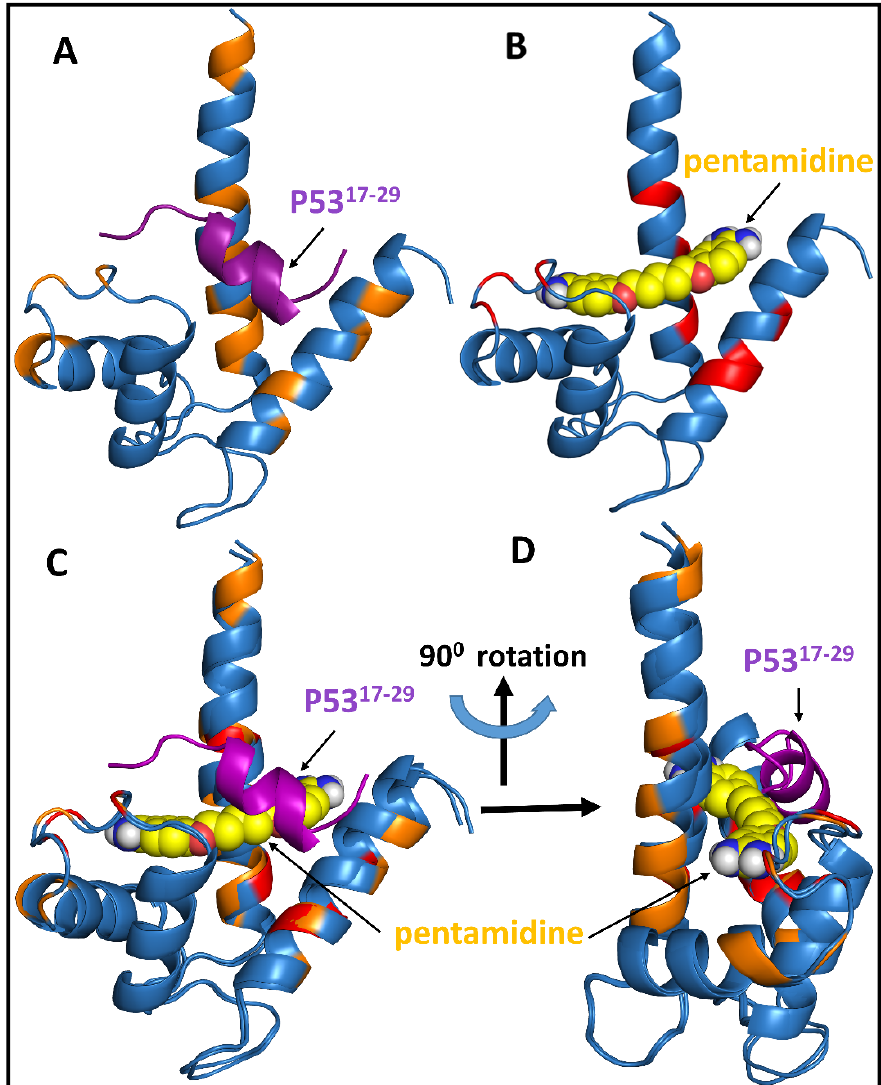
Figure 6. Two complex structures S100P-p53 17-29 and S100P-pentamidine were superimposed. ( A ) The S100P-p53 17-29 complex is shown in blue (S100P) and purple (p53 17-29 ), and ( B ) the S100P-pentamidine complex is shown in blue (S100P) and yellow (pentamidine). ( C ) the overlapping structures of ( A ) and ( B ). ( D ) 90 ° angle rotation of ( C ). Figure 6D, pentamidine clearly blocked the binding between S100P (blue) and p53 17-29 (purple).